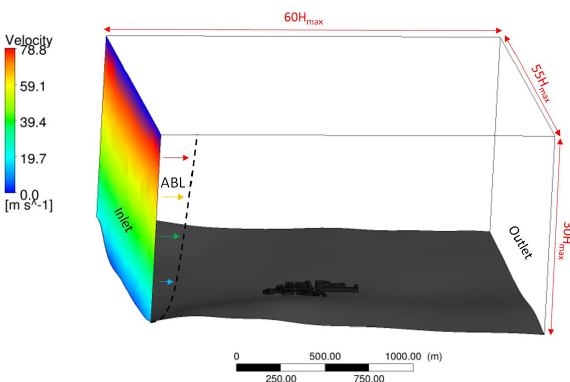
Figure 5. CFD simulation domain. Velocity on vertical line: profile of the atmospheric boundary layer at